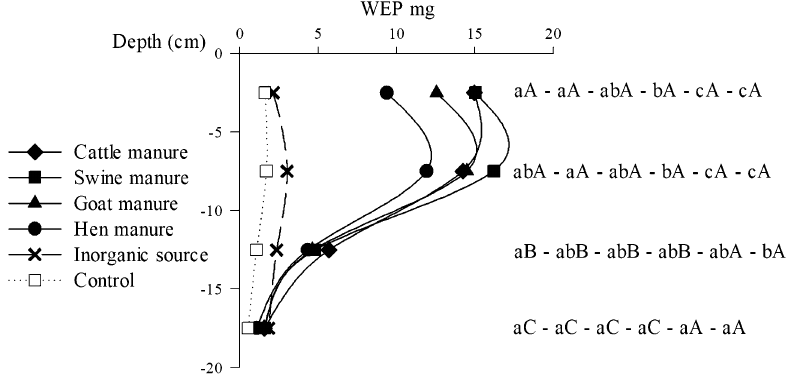
Fig. 3 Distribution of concentrations of P extracted with water from 20-cm columns filled with Dystric Xeropsamments after application of 10 PV. Treatments followed by the same letter do not differ sig- nificantly by Tukey test ( p < 0.1); lower case letters compare sources